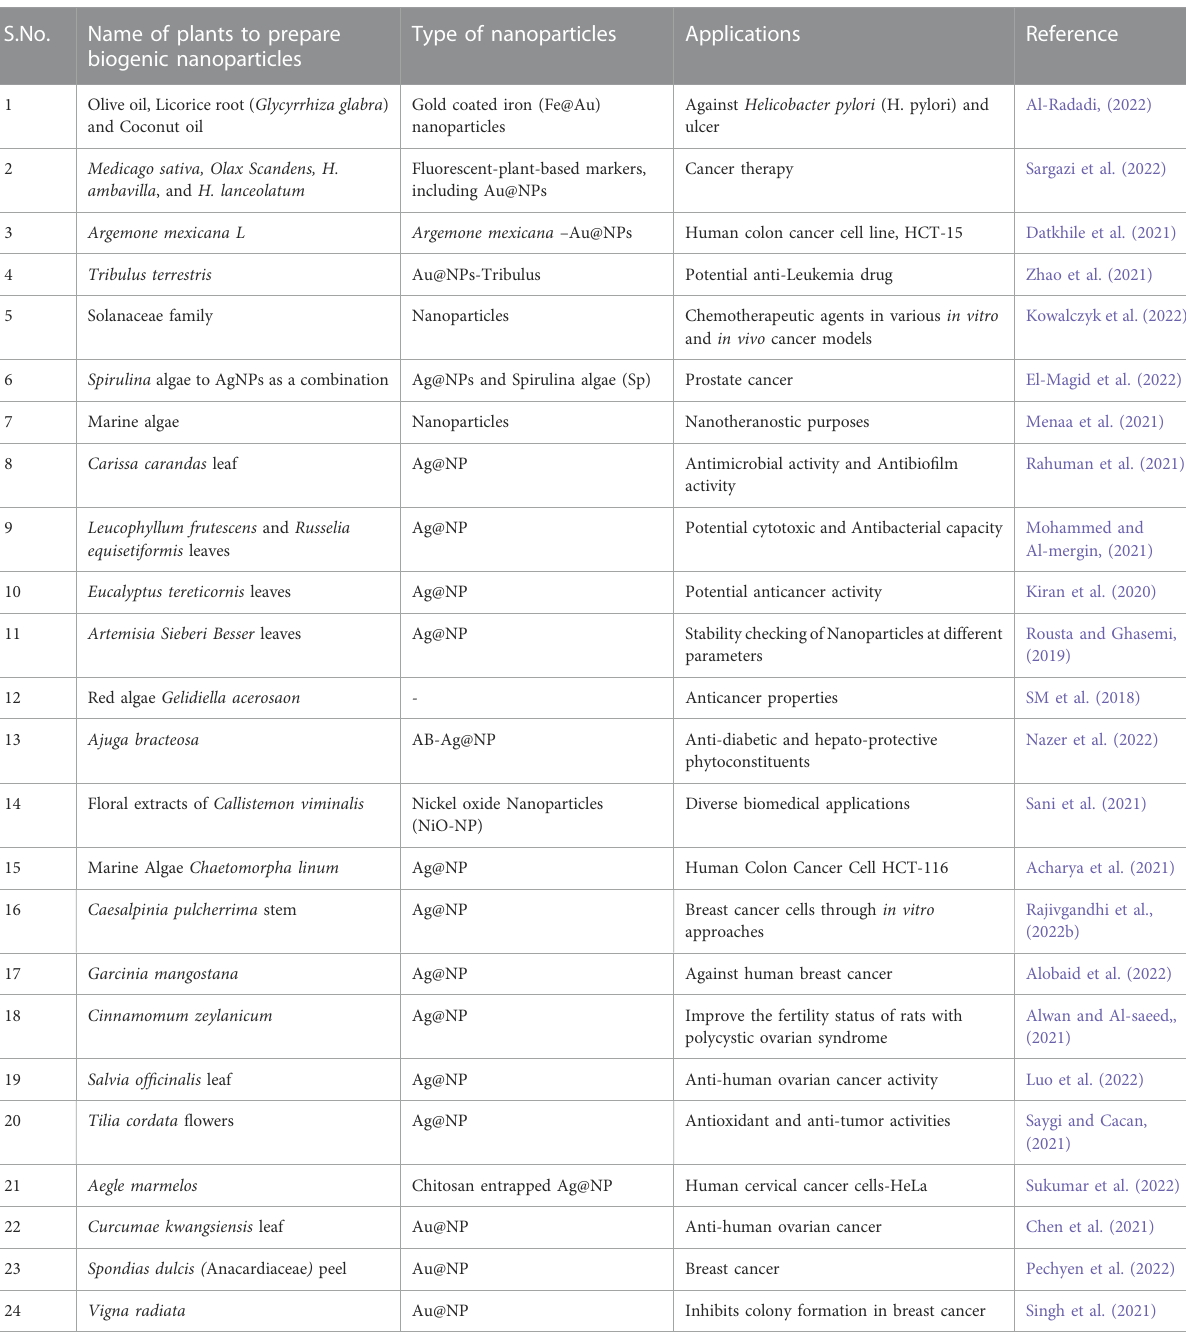
TABLE 3 Plant used to form gold and silver nanoparticles along with their applications.